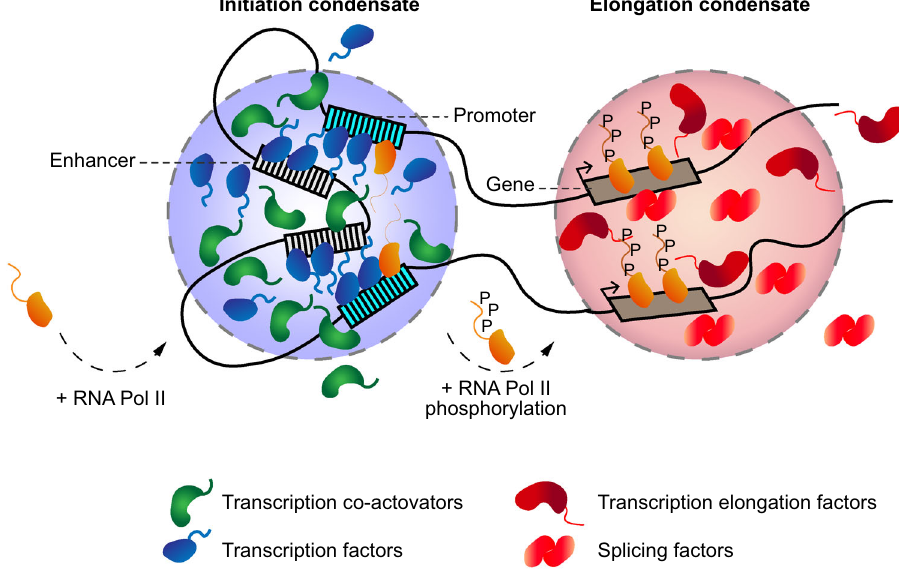
Fig. 2 LLPS in transcriptional regulation. Biomolecular condensates composed of transcription factors and coactivators at super-enhancers and promoter sequences recruit RNA Pol II. Phosphorylation of RNA Pol II mediates its transition from the initiation condensate to the elongation condensate, which is composed of transcriptional elongation and splicing